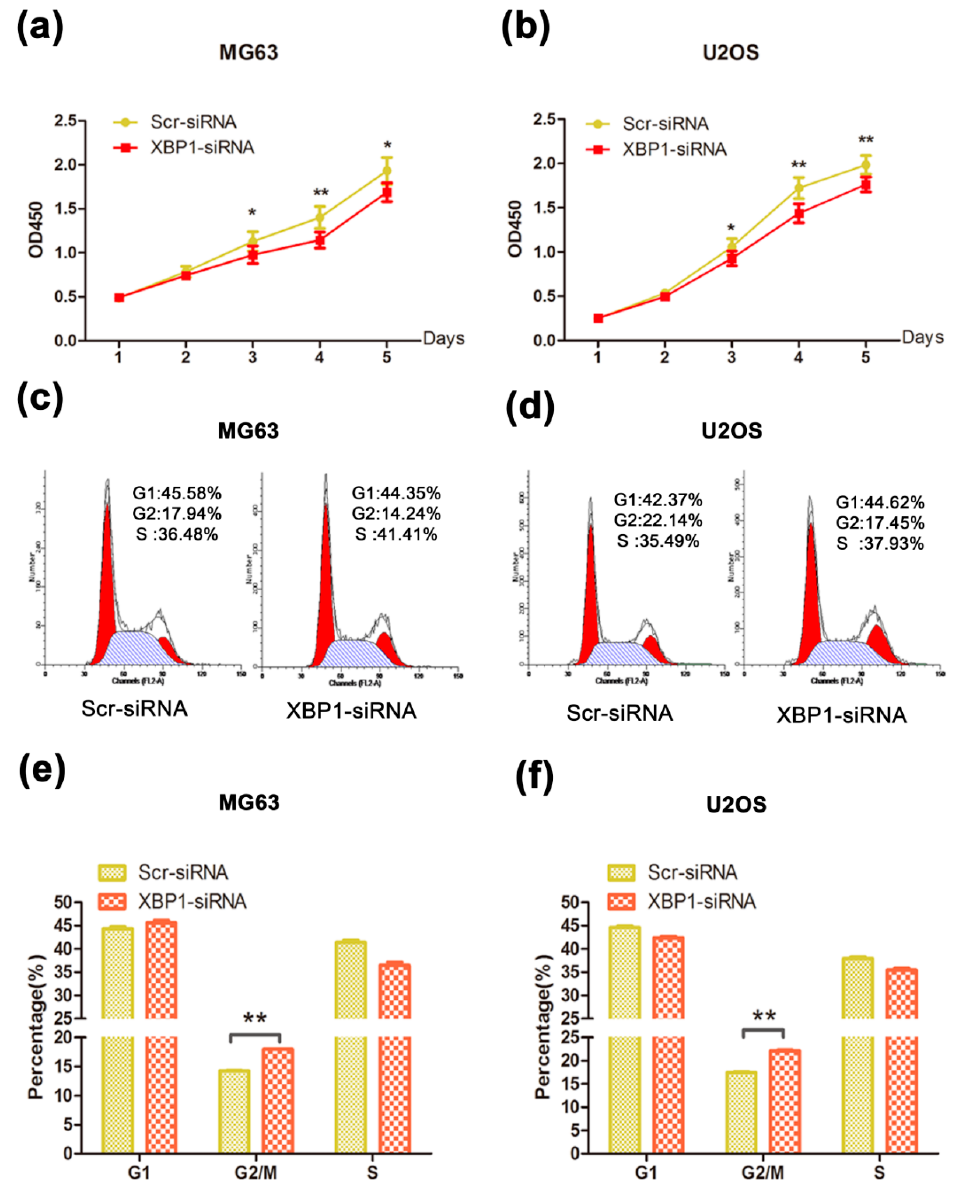
Figure 2. ( a , b ) Knockdown of XBP1 inhibited the growth and proliferation in OS cells. The viability of MG63 and U2OS was examined by CCK8 assay at different time points as indicated; ( c , d ) Flow cytometry of cell distribution after transfection; ( e , f ) Histograms of each phase in cell cycle of MG63 and U2OS. Silencing XBP1 increased cell proportion of G2/M phrase in MG63 and U2OS cells. Data represent mean ± s.d. Each performed in triplicate. * p < 0.05, ** p < 0.01, by Student’s t -test. Transfected cells was treated in the hypoxia (24 h) chamber before the assays.